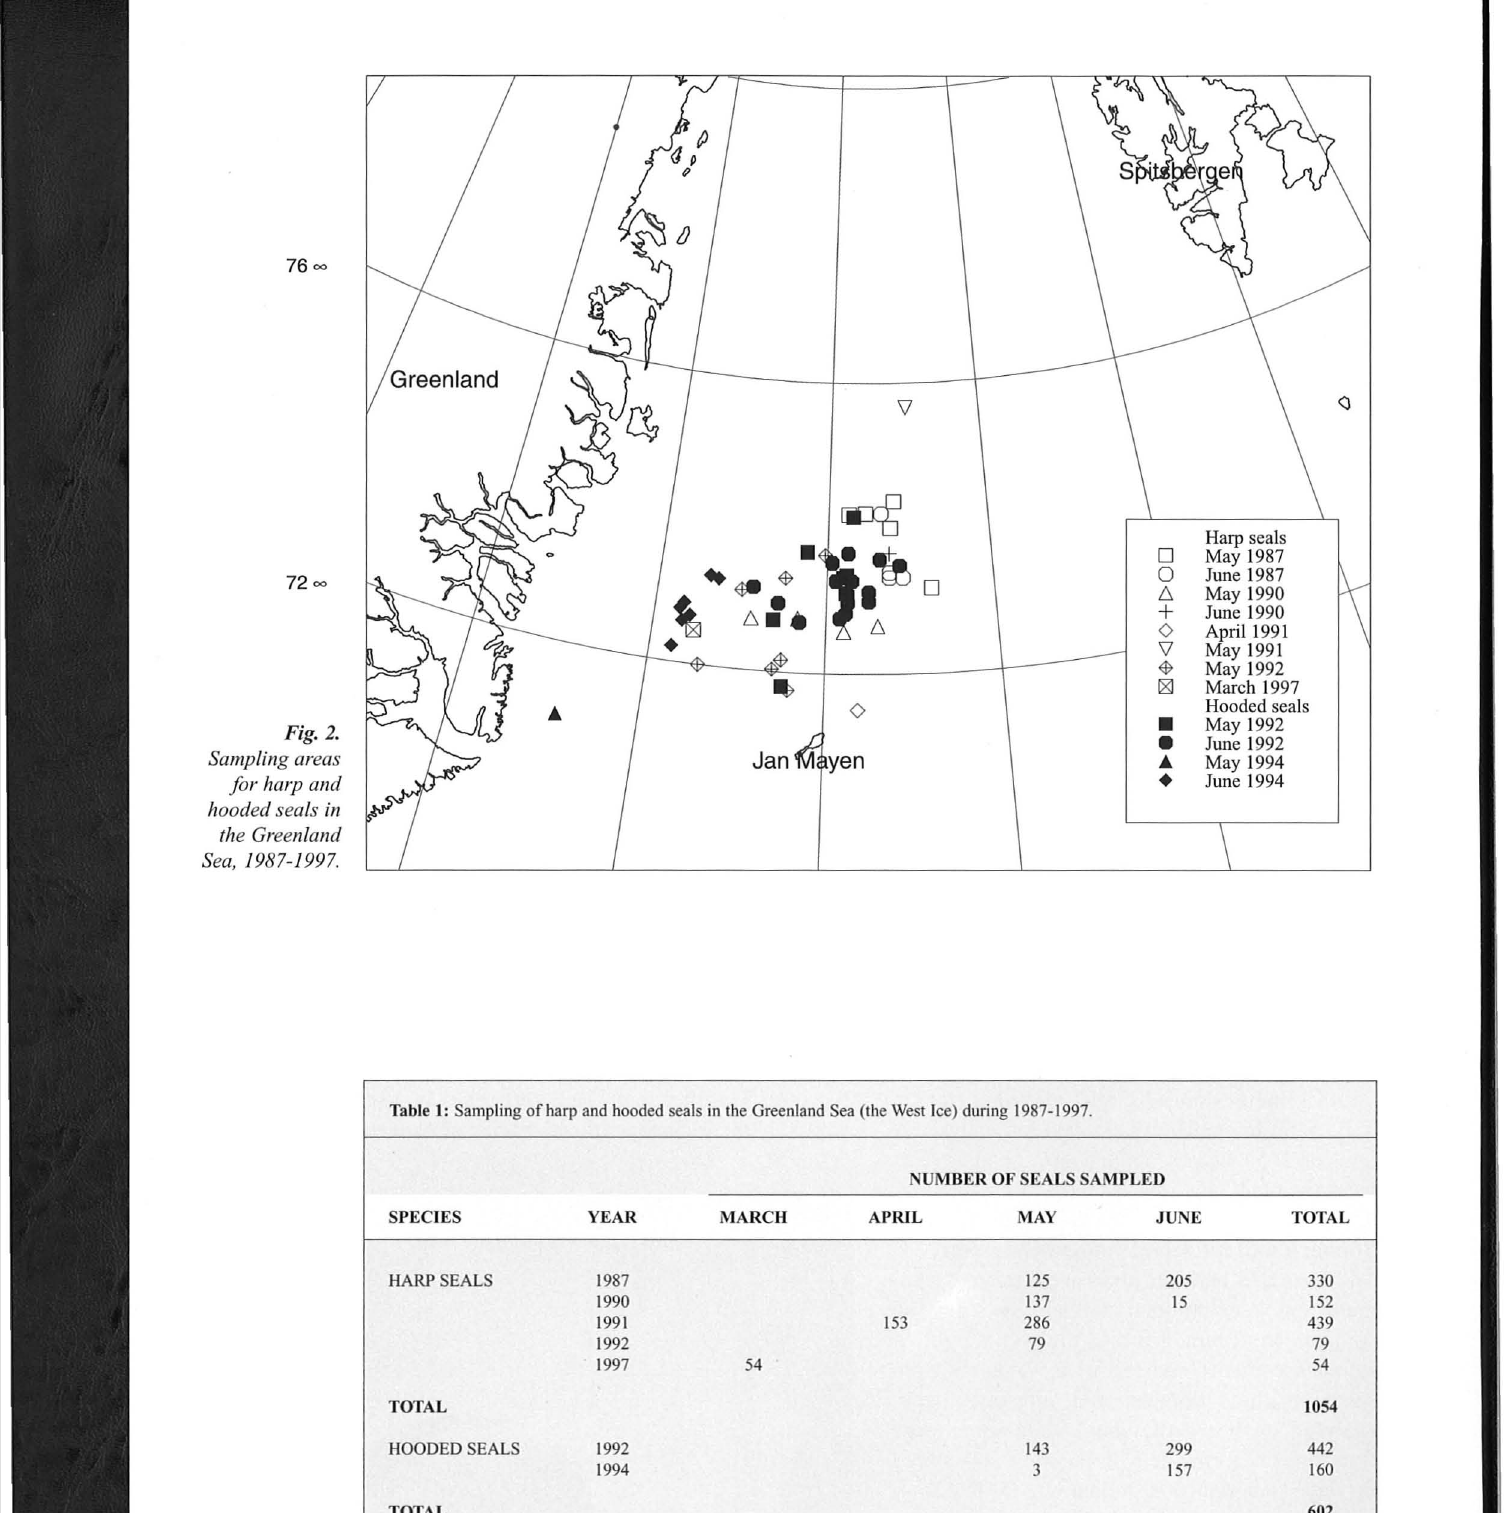
NUMBER OF SEALS